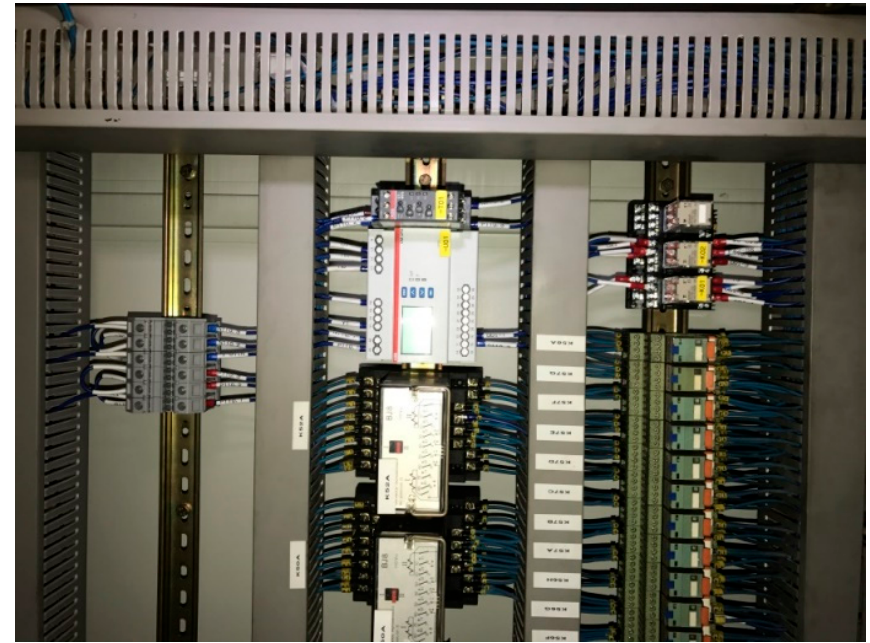
Figure 33. The panel after installing the relay.